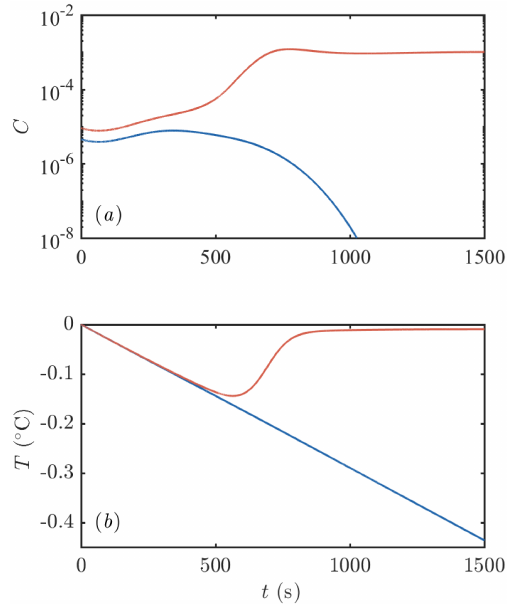
Figure 3. Example of the evolution of (a) frazil-ice concentration and (b) supercooling after an initial seeding event. One calcula- tion is initialized with slightly more crystals than the other: the red curve has an initial crystal number density of 10 6 m − 3 com- pared to 5 × 10 5 m − 3 for the blue curve. The former leads to a frazil-ice explosion with a large concentration of ice and all the su- percooling exhausted. The latter eventually loses all of the ice ini- tially present. Calculations were performed with Q = 1200Wm − 3 , (cid:15) = 5 × 10 − 3 m 2 s − 3 , D = 1m, e n max = 4 × 10 6 m − 3 , R 0 = 0 . 2mm, and H = 0 . 05mm. The parameter values are similar to Svensson and Omstedt